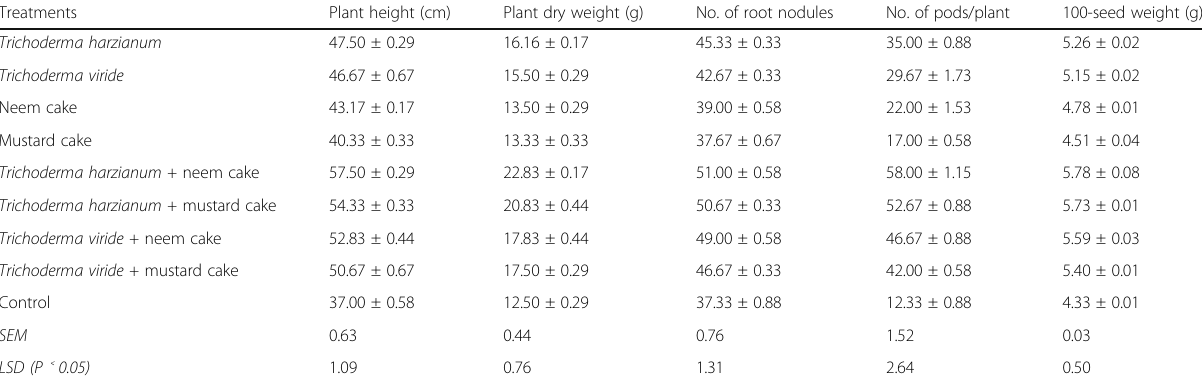
Table 2 Effect of the application of the tested bioagents and organic amendments on the morphological and crop parameters of mungbean Treatments